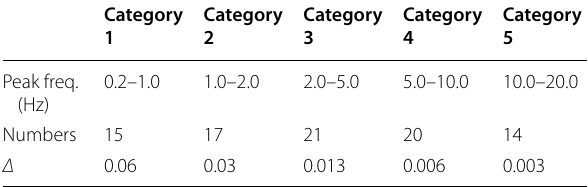
Table 3 Detailed statistics of five